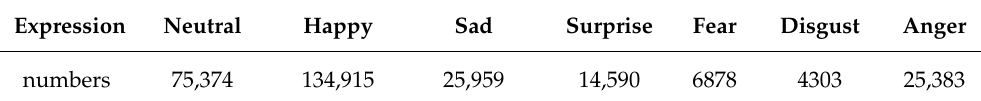
Table 2. Sample data from the AffectNet datasets, which originally had 11 classes. We extracted the seven expression classes that we needed from the datasets, as shown below. There are 134,915 happy and 75,374 neutral expressions, which are significantly more than fear, disgust, and anger